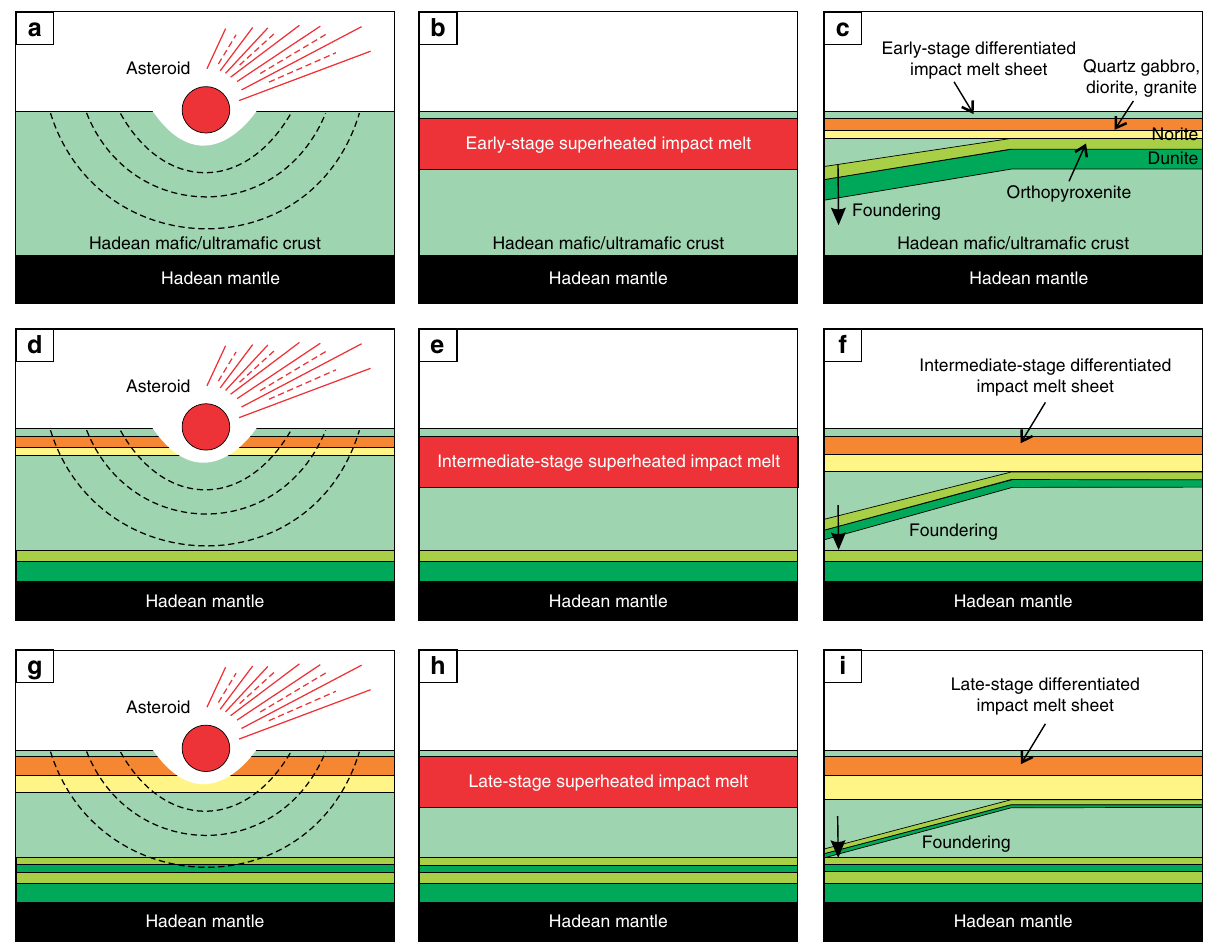
Fig. 10 Model for the proposed compositional evolution of the Hadean ma fi c/ultrama fi c proto-crust due to fractional crystallization of impact melt sheets followed by delamination of their ultrama fi c portions. a – c Early Stage. A large asteroid caused melting of the Hadean proto-crust X (Fig. 9a) and generated a sheet of homogeneous and superheated impact melt. After cooling, the impact melt has differentiated into a well-strati fi ed igneous body with ultrama fi c cumulates (dunite and orthopyroxenite) substantially predominating over the ma fi c-to-felsic ones (norite, quartz gabbro, diorite and granite). Ultrama fi c cumulates are denser than proto-crust (Fig. 9) and therefore they foundered towards the crust-mantle boundary 51,52 . Fractional crystallization sequence is shown in Fig. 9a, b; d – f Intermediate Stage. A large asteroid caused melting of the Hadean proto-crust together with ma fi c-to-felsic cumulates from the previous impact event and generated a layer of homogeneous and superheated impact melt. After cooling, the impact melt has differentiated into a well- strati fi ed igneous body in which ma fi c-to-felsic cumulates started prevailing over the ultrama fi c ones. This is followed by foundering of dense ultrama fi c cumulates that resulted in enriching the proto-crust in compositionally evolved cumulates. Fractional crystallization sequence is shown in Fig. 9c, d; g – i Late Stage. A large asteroid caused melting of the Hadean proto-crust together with ma fi c-to-felsic cumulates from the previous impact event and generated a layer of homogeneous and superheated impact melt. After cooling, the impact melt has differentiated into a well-strati fi ed igneous body in which ma fi c-to- felsic cumulates substantially predominate over the ultrama fi c ones. This is again followed by foundering of dense ultrama fi c cumulates that further enriches the proto-crust in compositionally evolved cumulates. Fractional crystallization sequence is shown in Fig. 9e, f. The ultimate result of this